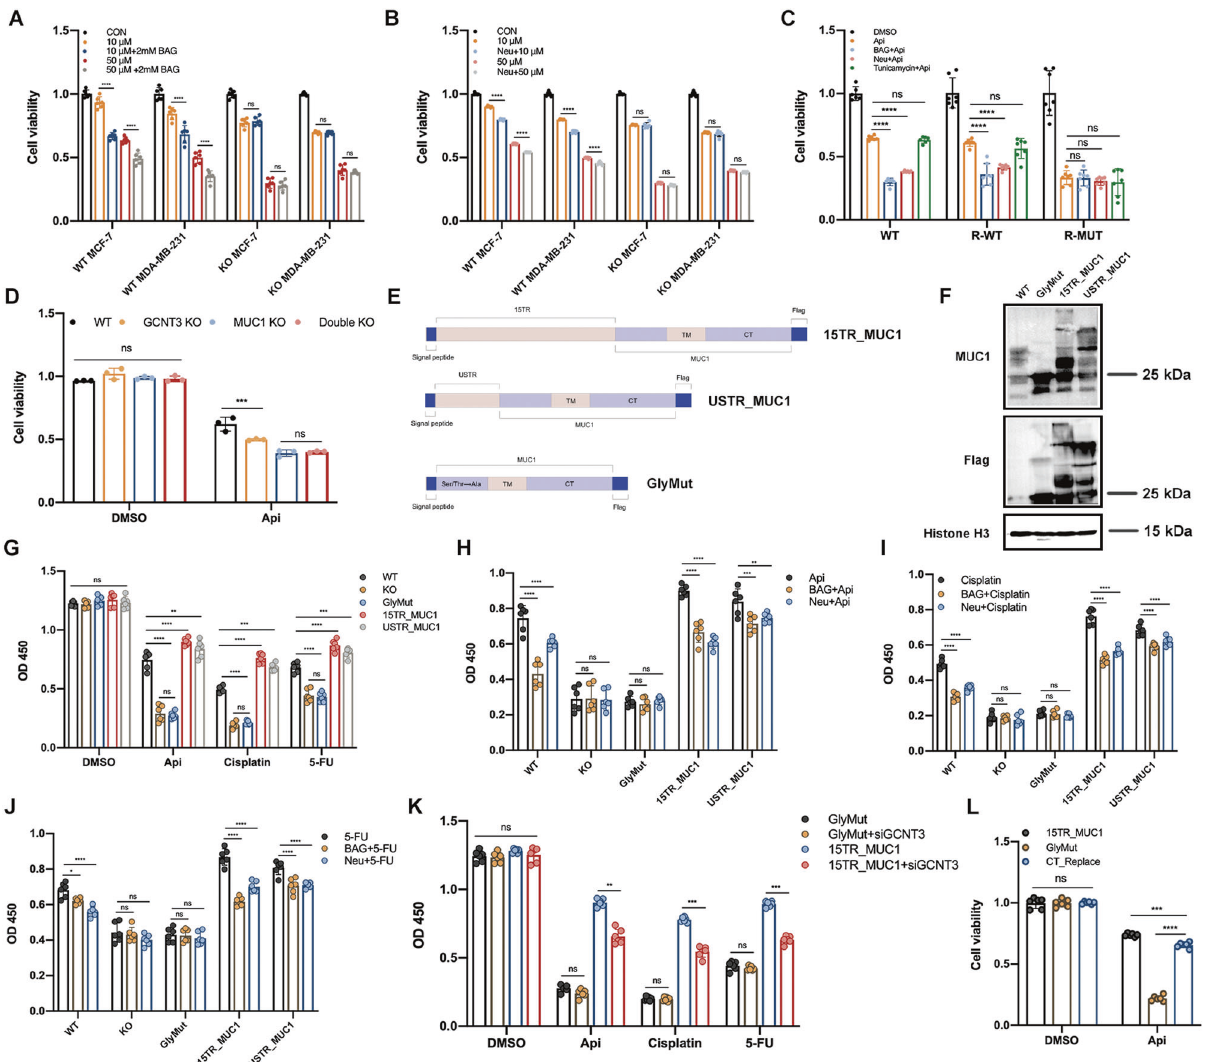
viability of four cell lines (WT, GCNT3 KO, MUC1 KO, and Double KO) treated with 50 μ M apigenin for 48 h. E The diagram of plasmids construction. F Western blot veri fi cation of MUC1 O-glycosylation in WT, GlyMut, 15TR_MUC1, and USTR_MUC1 cell lines. G OD value of fi ve cell lines after drug treatments. H OD value of fi ve cell lines pretreated with BAG or Neu post apigenin treatment for 48 h. I OD value of fi ve cell lines pretreated with BAG or Neu post cisplatin treatment for 48 h. J OD value of fi ve cell lines pretreated with BAG or Neu post 5-FU treatment for 48 h. K Cell viability of GlyMut and 15TR_MUC1 with/without siGCNT3 treated with indicated drugs. L Cell viability of 15TR_MUC1, GlyMut, and CT_Replace cells treated with DMSO or 50 μ M apigenin for 48 h. Each group was analyzed in triplicate. * P < 0.05; ** P < 0.01; *** P < 0.001 for